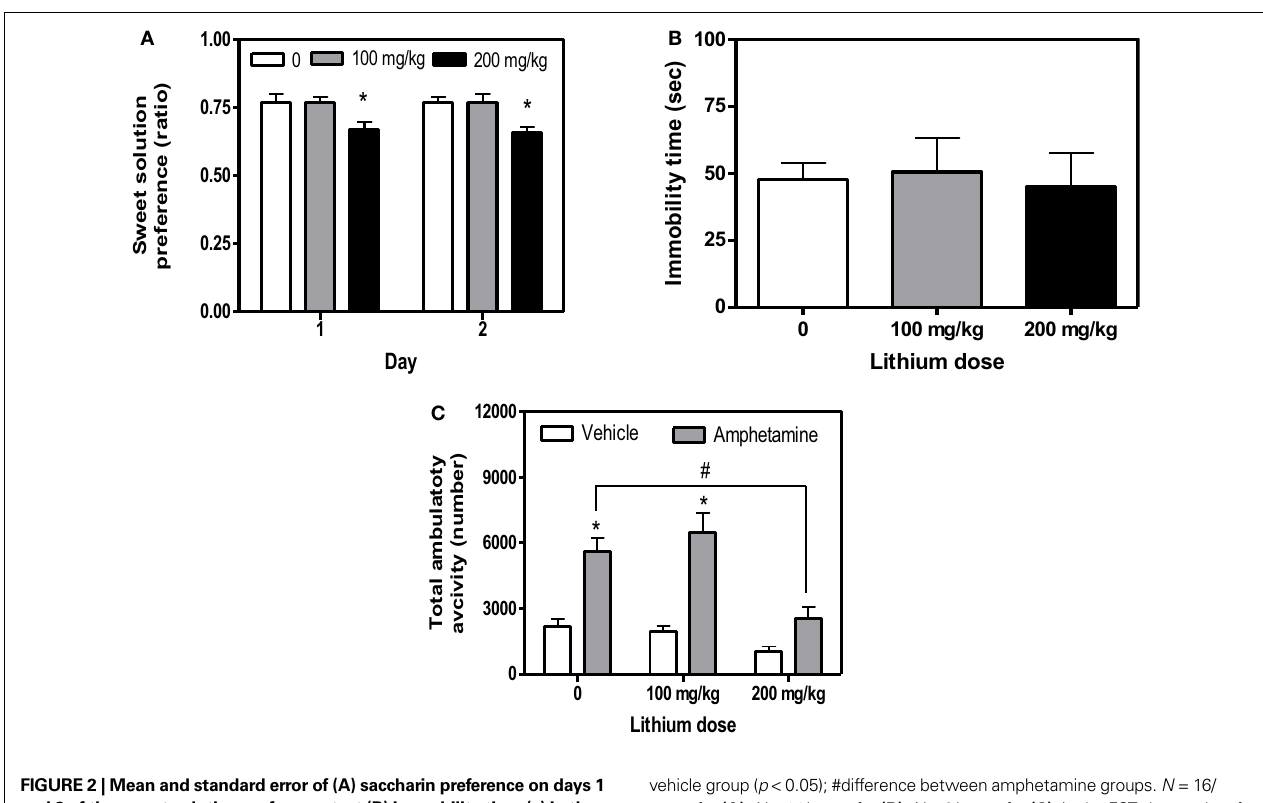
vehicle group ( p < 0.05); #difference between amphetamine groups. N = 16/ group for (A) , N = 14/group for (B) , N = 8/group for (C) . In the FST, the results of 2 mice from each group were excluded from the statistical analysis due to a system malfunction during the